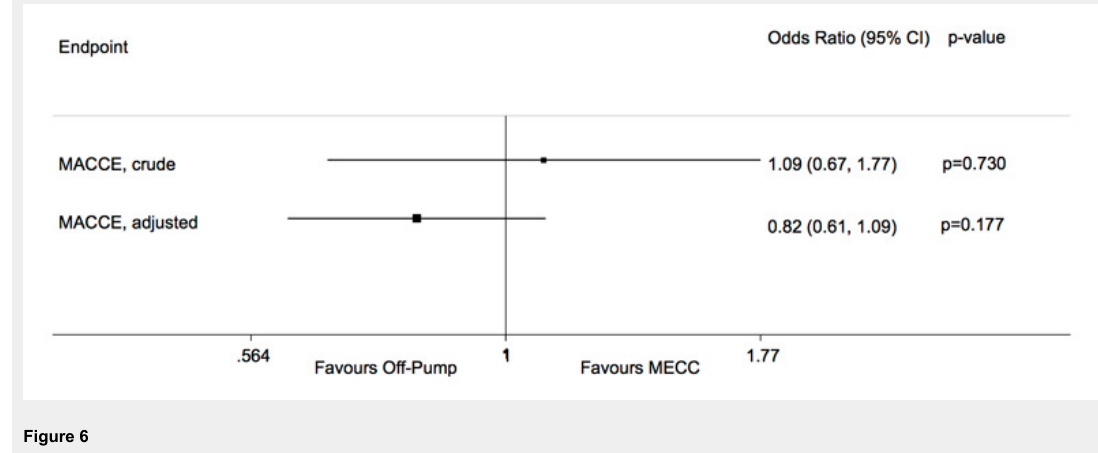
Figure 6 Forest plot regarding secondary endpoint